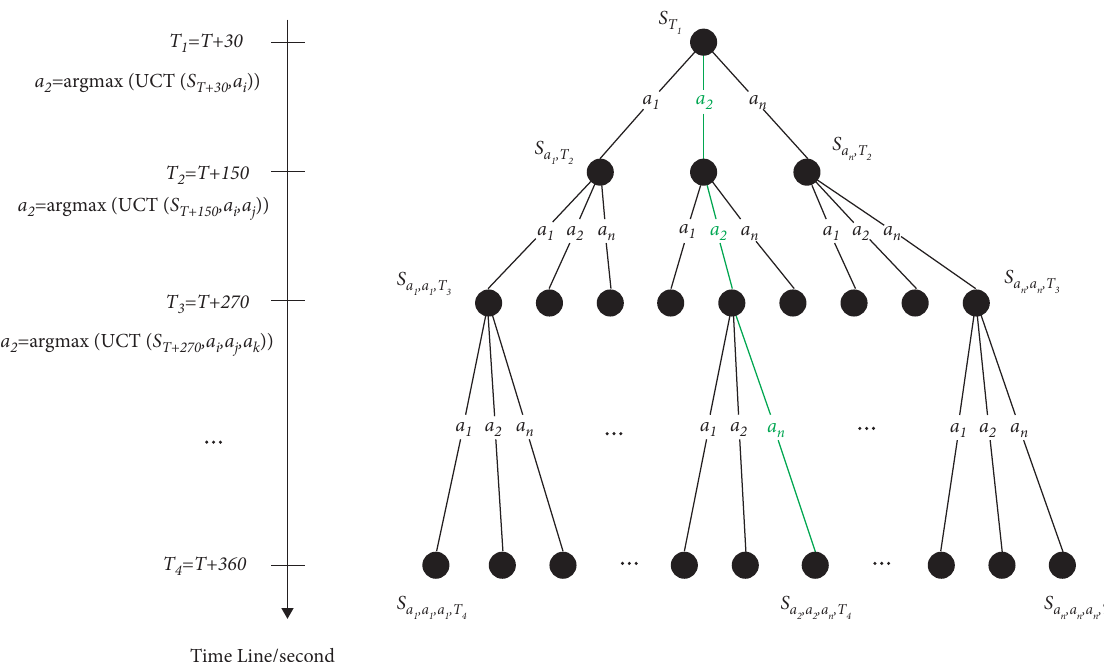
Figure 8: The tree search structure of the conflict resolution based on the MCTS.